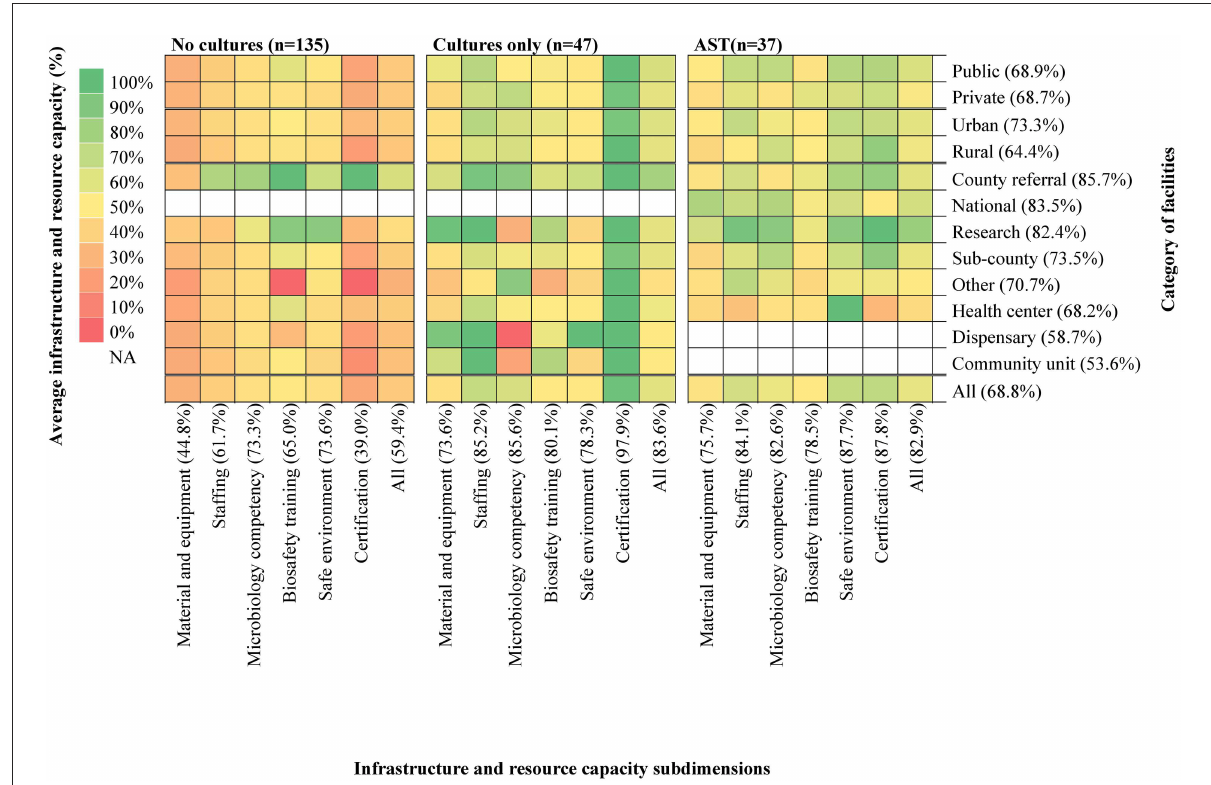
FIGURE4 The heat map details infrastructure and resource capacity scores of the study facilities. The list to the right of the map indicates category names for facility affiliation (Private, Public) urbanicity (Rural, Urban) and level (National referral, Research, County referral, County, Health Centers, Dispensaries and Community units). The category “Other” includes facilities of non-public ownership that fall outside the 6-level structure of the Kenyan health system. The list below indicates the subdimensions of assessment for infrastructure and resource capacity. Indices in parentheses after each category name is the average capacity score of all cells in each row for left list and all cells in each column for list below. Categories are ranked in descending order of average capacity score for affiliation, urbanicity and level, respectively. AST, Antimicrobial Susceptibility Testing; NA, Not